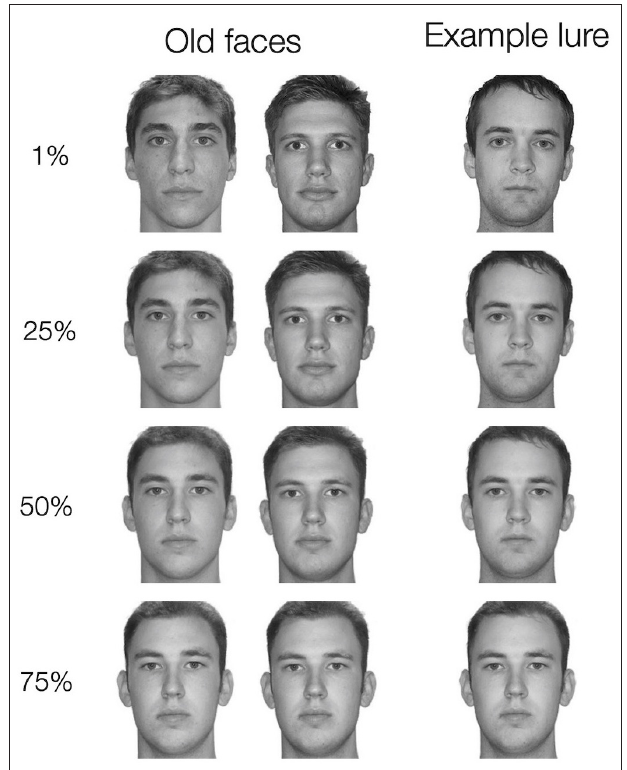
FIGURE 6 | Example recognition stimuli for Experiment 3. Faces in the first two columns represent an example pairmate from the training phase, which served as old faces during the recognition test. The second column represents an example new (lure) face. Each row shows the example pairmate at corresponding lure at a different blend level with the lure always matching the blend level of the associated pairmate. During the experiment, each pairmate and lure would be shown at one blend level. All the faces depicted come from the Dallas Face Database ( Minear and Park,